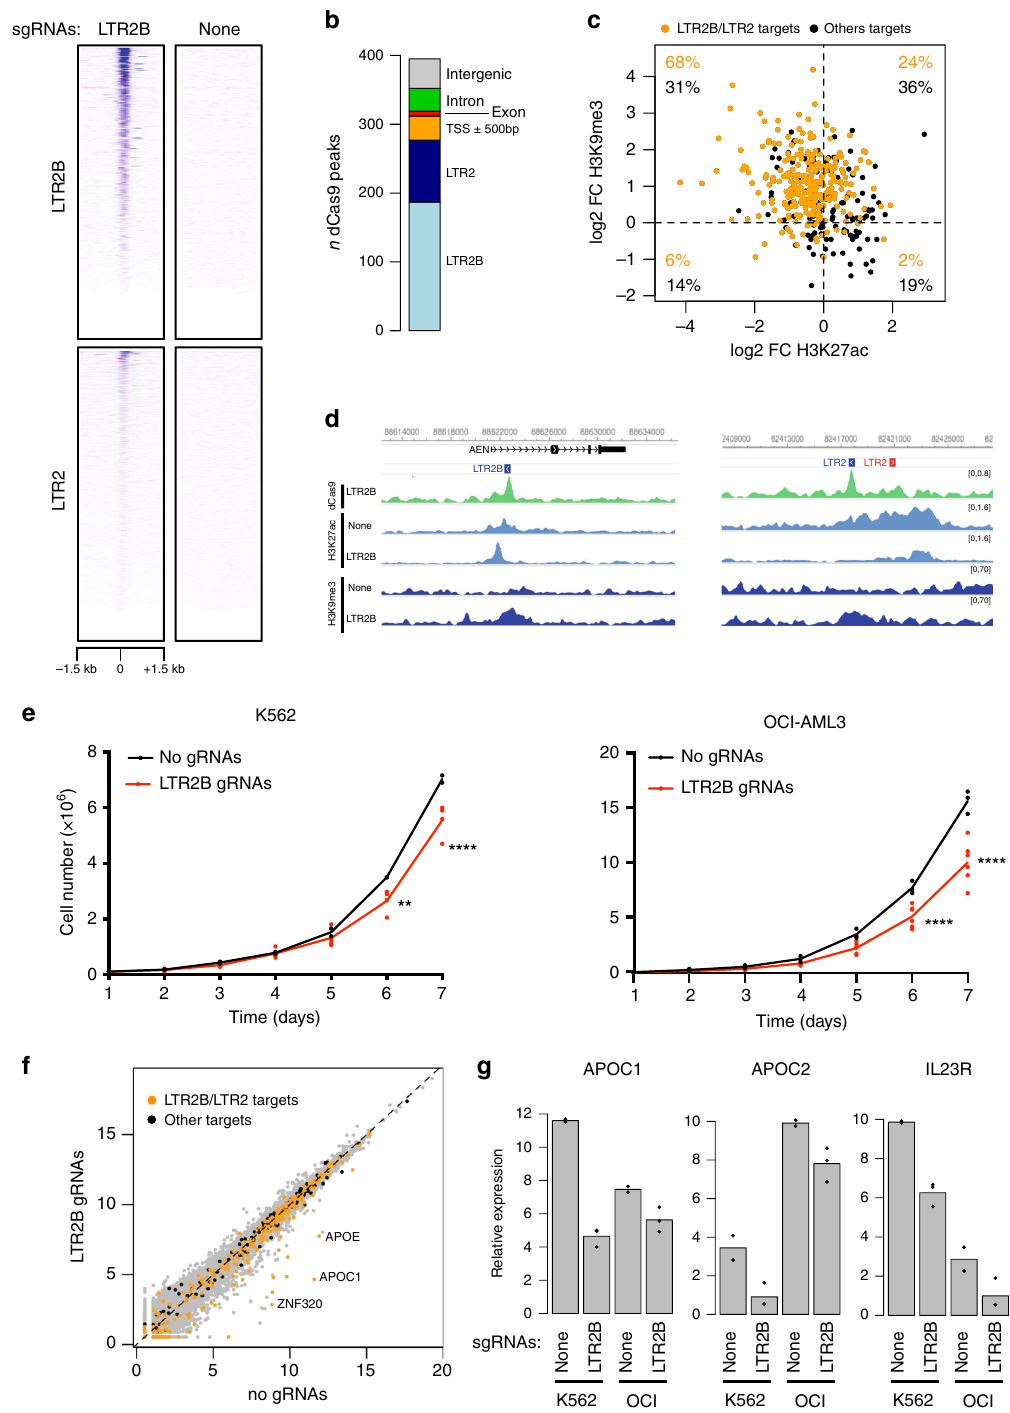
Fig. 5 CRISPRi of LTR2B/LTR2 elements leads to impaired cell growth. a Pro fi le of dCas9 ChIP-seq signal over LTR2B and LTR2 elements in K562 cells expressing LTR2B sgRNAs or an empty vector ( “ None ” ). b Number of dCas9 peaks overlapping LTR2 and LTR2B elements, or other genomic features. c Log2 ratio of the ChIP-seq signal at dCas9 peaks (1 kb regions from the centre of each peak) between K562 cells expressing LTR2B sgRNAs or empty vector. Orange points highlight dCas9 peaks overlapping LTR2B or LTR2 elements. d Two examples of LTR2B/LTR2 elements targeted by dCas9, showing decreased H3K27ac and increased H3K9me3. e Cell proliferation assay in K562 (left) and OCI-AML3 (right) cells expressing LTR2B sgRNAs or an empty vector. Data are from 2 (K562) or 3 (OCI-AML3) independent assay replicates (performed at least 5 days apart) from either one (no gRNA) or two different infections (LTR2B gRNAs). ** p = 0.0096 and **** p < 0.0001 (two-way ANOVA with Sidak ′ s multiple-comparison test). Source data are provided as a Source Data fi le. f Gene expression levels in K562 cells expressing LTR2B sgRNAs or empty vector. Orange points highlight genes within 50 kb of a dCas9 peak targeting LTR2B/LTR2 elements; black points refer to genes within 50 kb of other dCas9 peaks. g Comparison of expression changes at selected genes between K562 and OCI-AML3 ( “ OCI ” ) CRISPRi cells ( n = 3 biological